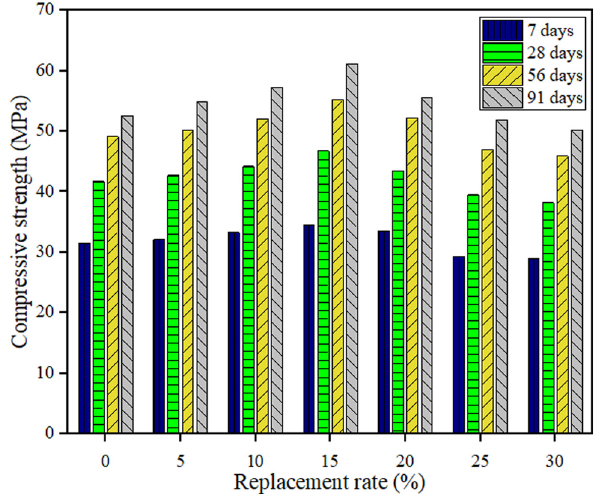
Figure 8: E ff ect of curing ages on the compressive strength of RHA – SCC mixtures [ 54 ] .